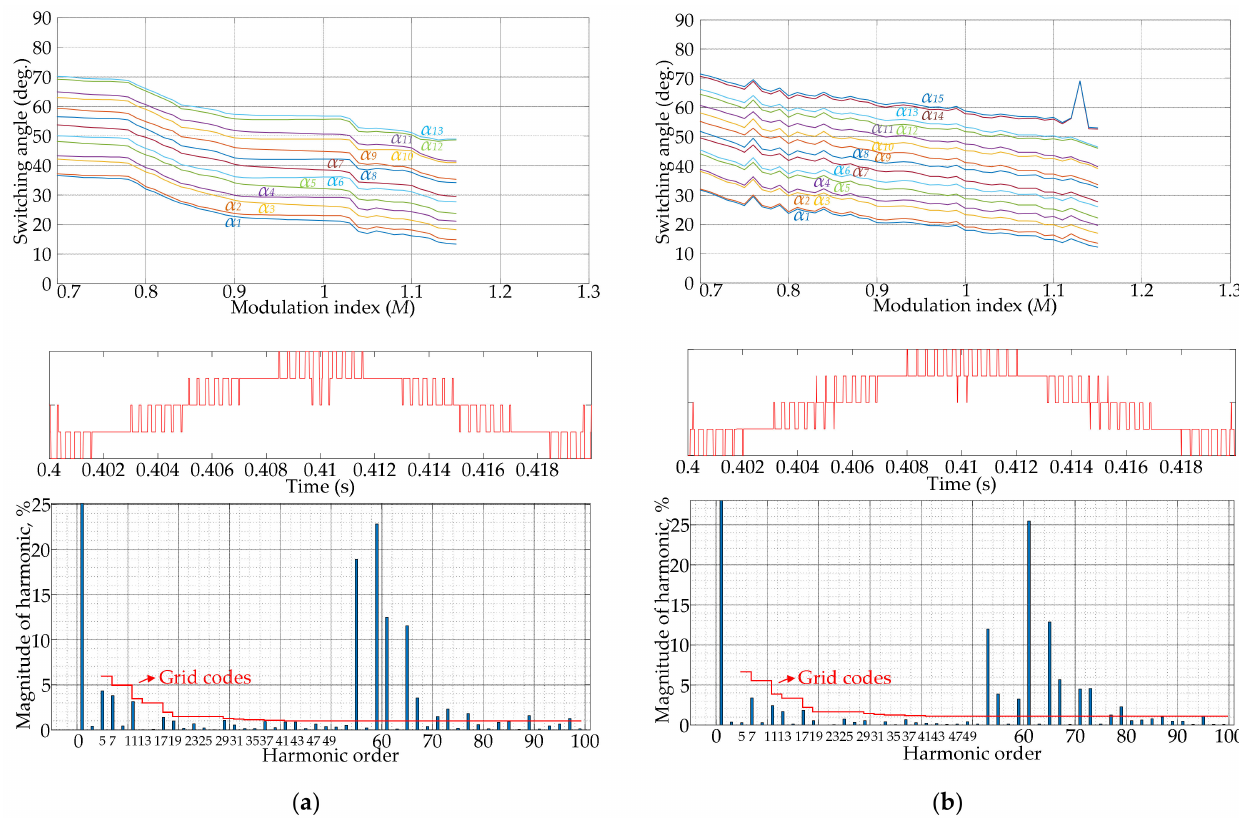
Figure 13. Results of solution trajectories, PPWM waveforms and FFT spectra based on fmincon function: ( a ) SHM problem with thirteen switching angles; ( b ) SHM problem with fifteen switching